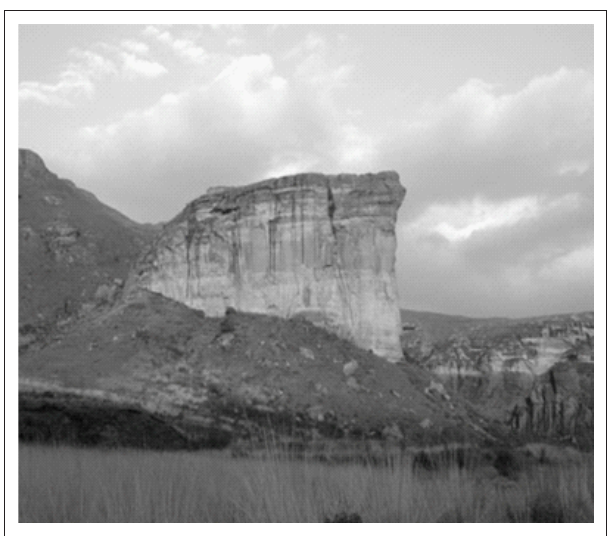
FIGURE 1: The Brandwag ‘Golden Gate’, displaying Clarens Formation sandstone